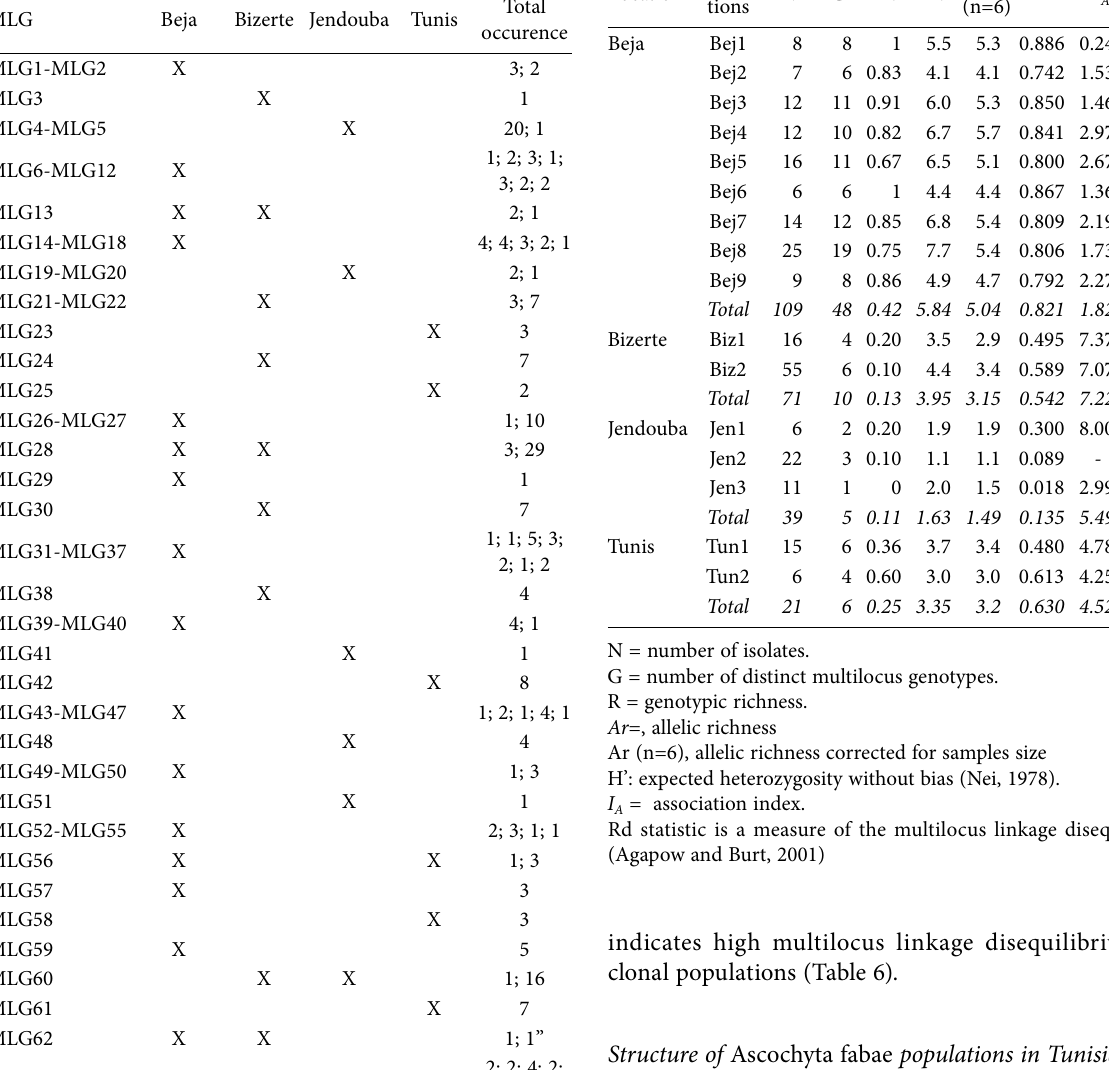
indicates high multilocus linkage disequilibrium and clonal populations (Table 6).